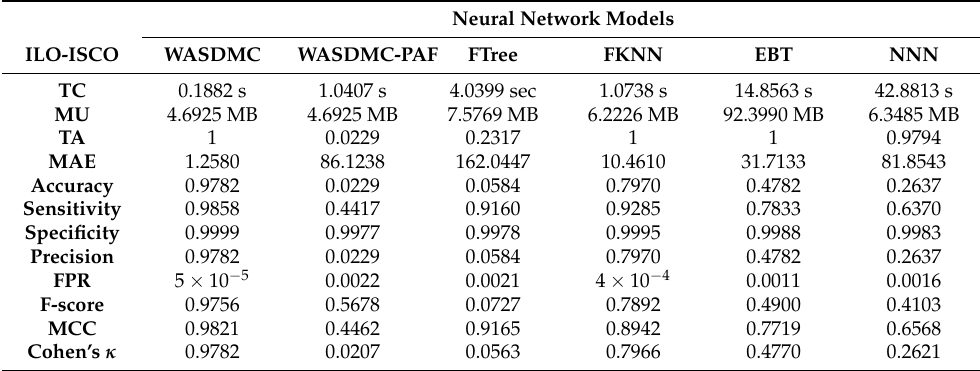
Table 1. The NN models’ statistics on the testing set of